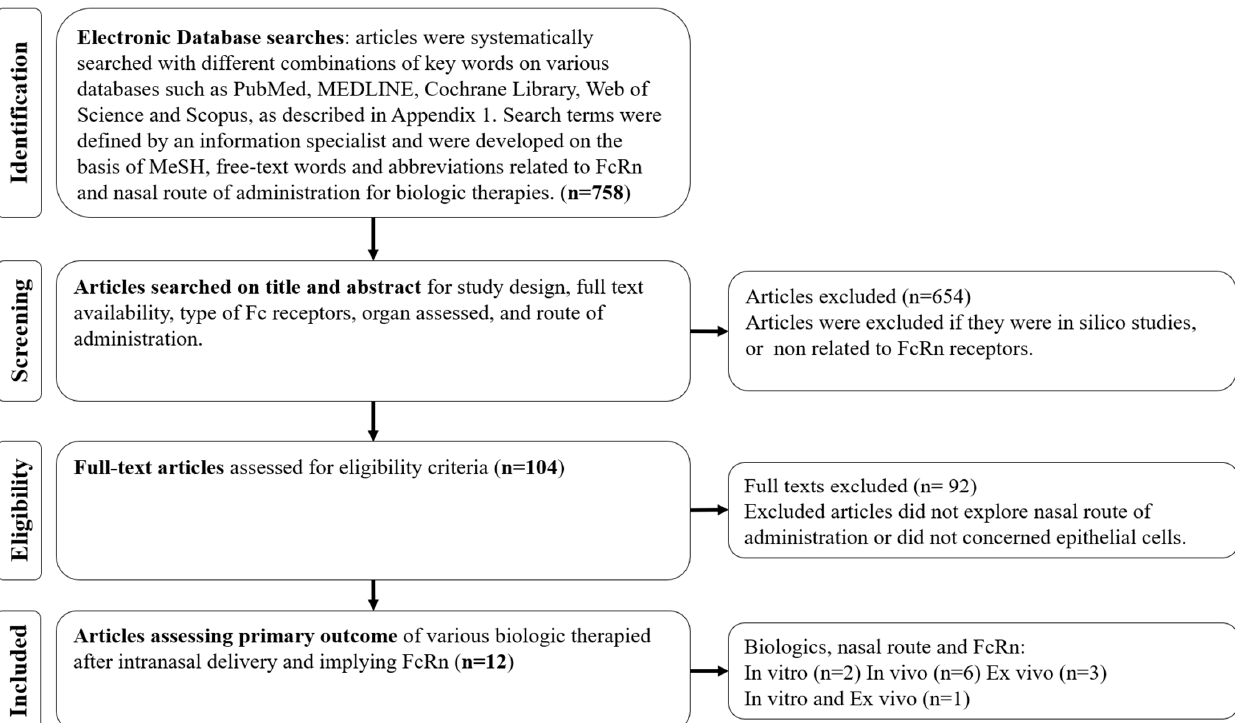
Figure 1. PRISMA Study Selection Flow Diagram. The PRISMA Flow Diagram demonstrates each phase of the search strategy in which articles were evaluated. During each phase, articles were excluded based on our eligibility criteria. Bold numbers correspond to the number of articles selected after each phase of the search strategy.